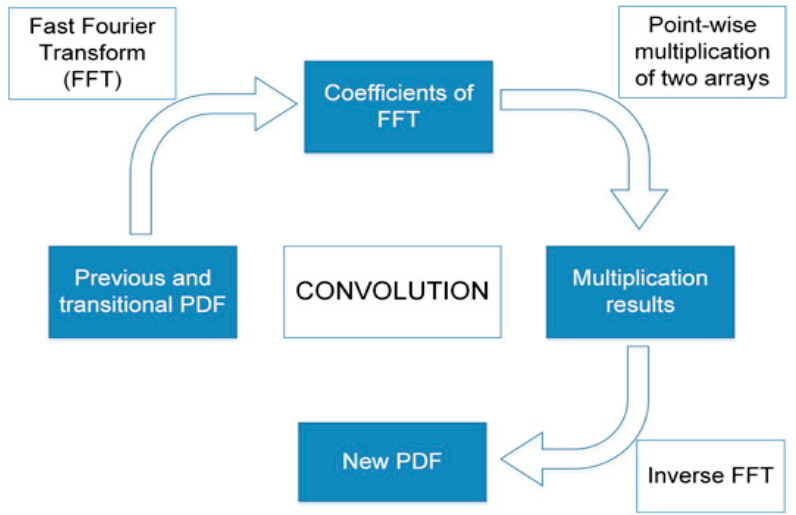
Figure 5. Implementation procedure of fast Fourier transform (FFT) convolution for Probability density function (PDF).